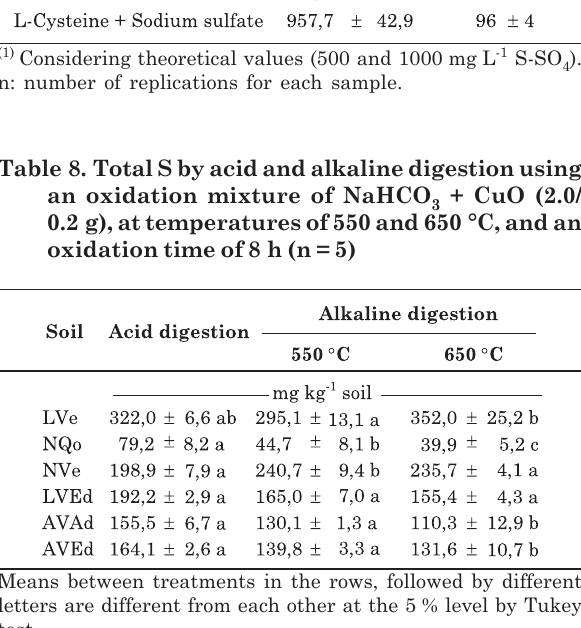
Table 9. Total S by acid and alkaline digestion using an oxidation mixture of NaHCO of 10/1 and 10/2), at 550 °C for 8 h (n =